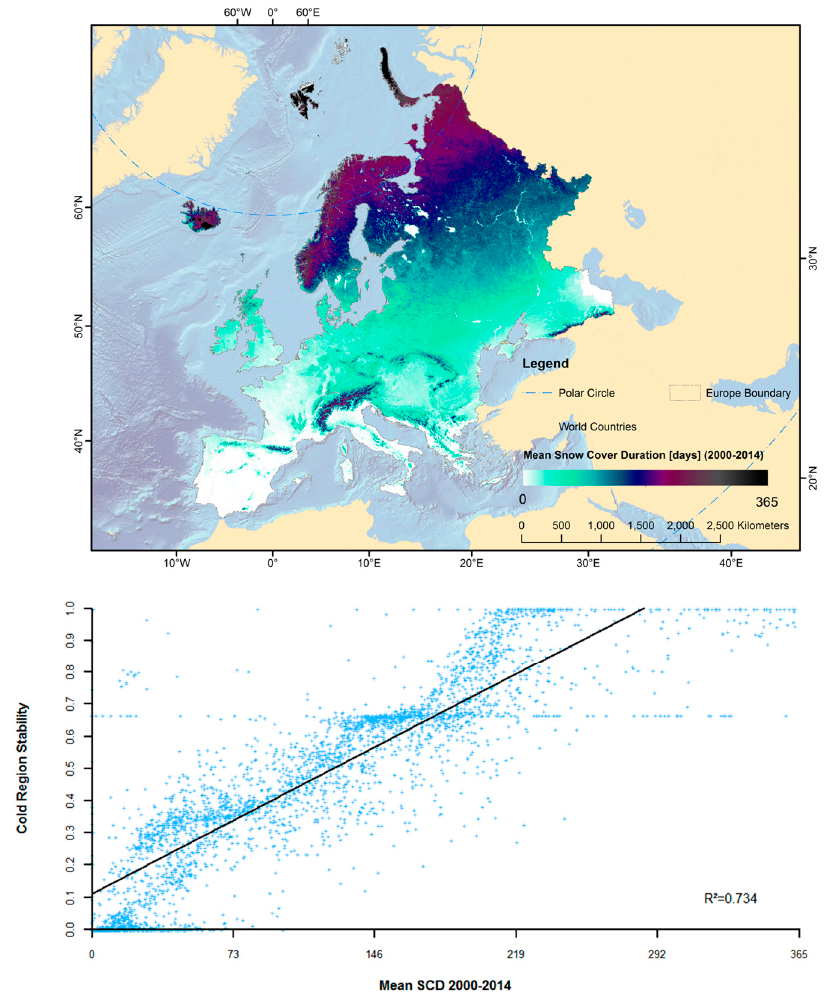
Figure 2. 15-year mean Snow Cover Duration (SCD) (2000–2014) derived from Global SnowPack data based on Dietz et al. [14] ( top ), and the scatter plot between mean SCD (2000–2014) and cold region stability ( bottom ). The two horizontal anomalous lines are artefacts due to the spatial resolution downscaling occurring in the mountain areas and their surrounding regions.